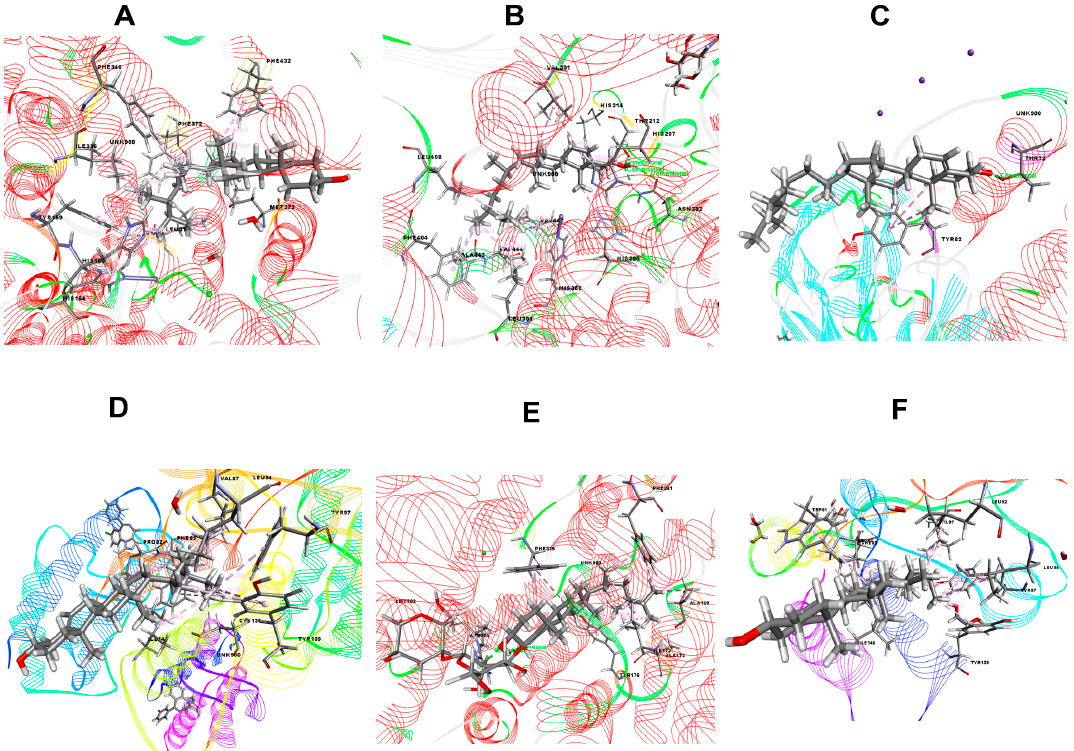
Figure 6. Best representations of beta-sitosterol in the binding pocket of ( A ) PDE4 enzyme (PDB ID: 4WCU), ( B ) COX 2 enzyme (PDB ID: 6COX), ( C ) potassium channel (PDB ID: 4UUJ), ( D ) bromodomain of human BRD4 in complex with midazolam (PDB ID: 3U5K), ( E ) serotonin transporter (PDB ID: 5I6X), and ( F ) bromodomain of human BRD4 in complex with alprazolam (PDB ID: 3U5J).